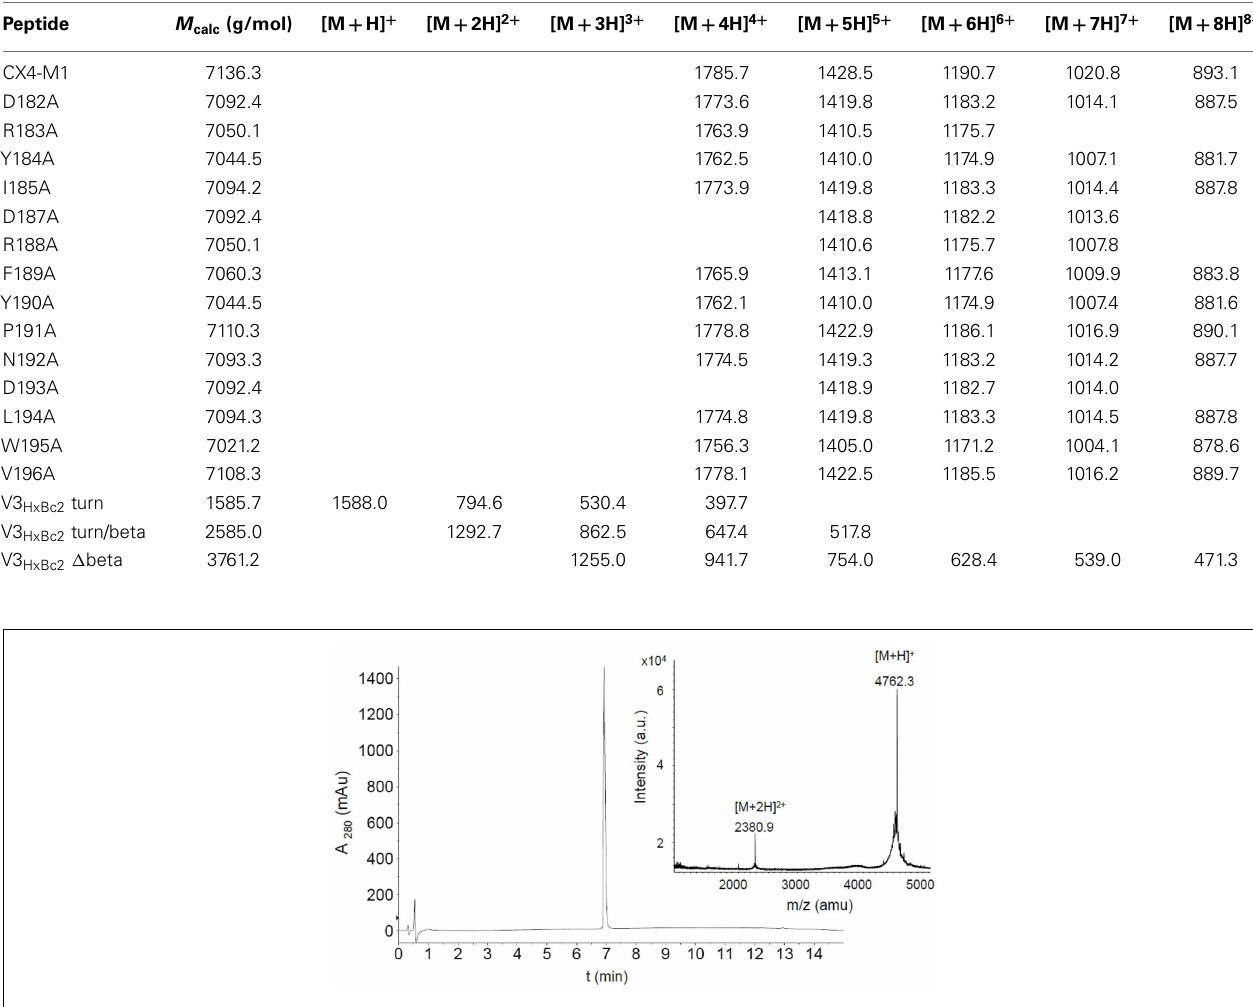
Table 2 | ESI-mass spectrometry data of synthesized peptides.